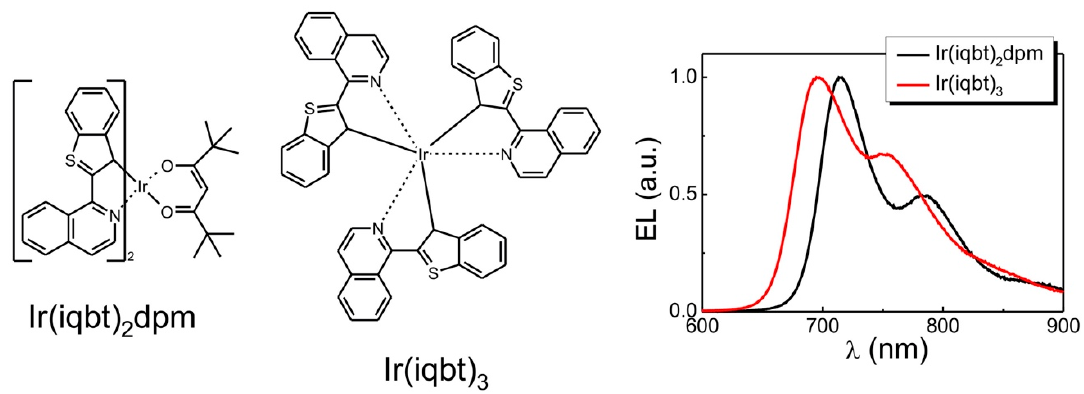
Figure 1. Chemical structures of the NIR-emitting iridium complexes and their EL spectra.